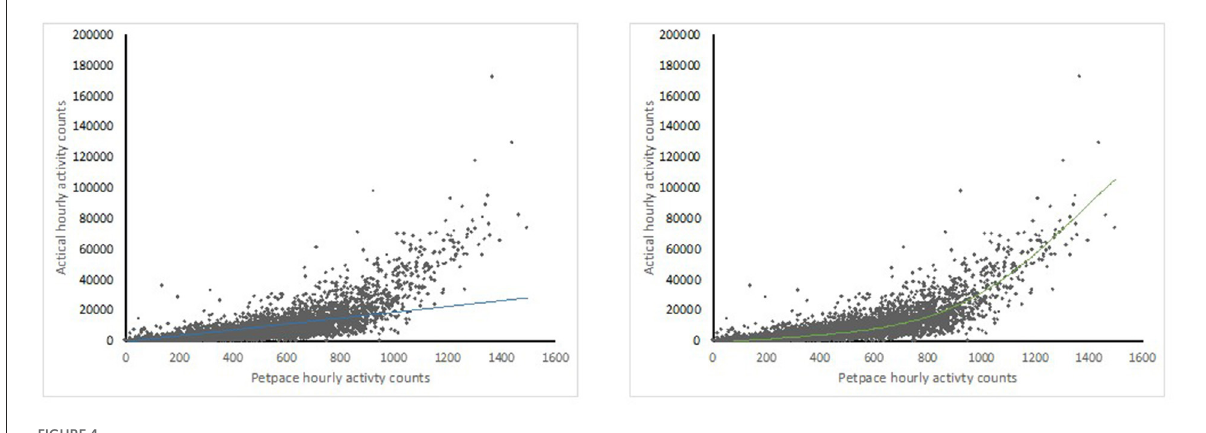
FIGURE4 Scatter plot graphs showing correlations between sums of activity counts per hours between Actical (y) and PetPace (x) monitors with linear (left) and 5th order polynomal (right) best fit lines.